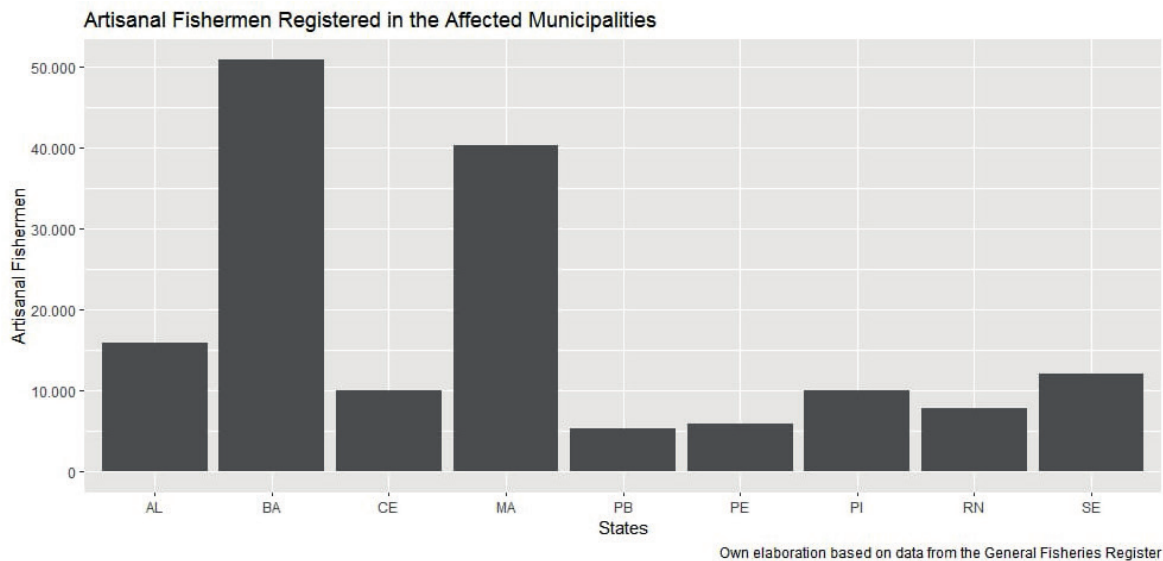
Figure 4. Artisanal Fishermen Registered in the Affected